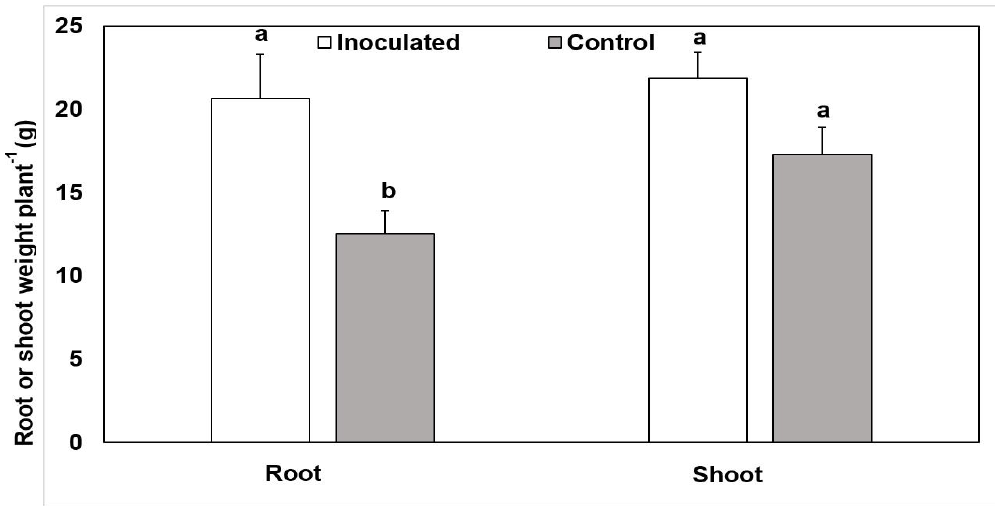
Figure 3. Root and shoot weights (g) of inoculated and control Douglas-fir seedlings at harvest. Data are the mean of 12 replicates. Error bars show the standard deviation. Means designated with different letters are significantly different.